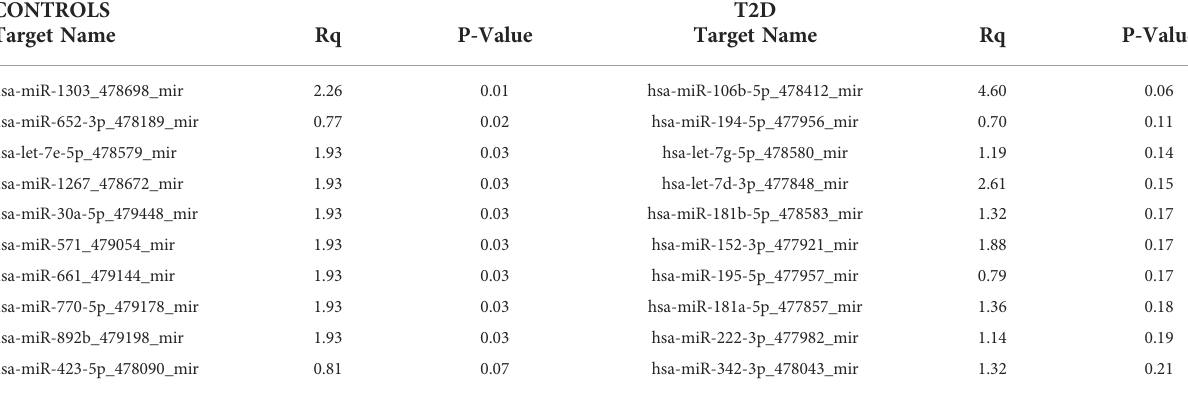
TABLE 2 Top 10 miRNAs that changed from baseline to hypoglycemia in T2D and control subjects in the validation experiment. CONTROLS